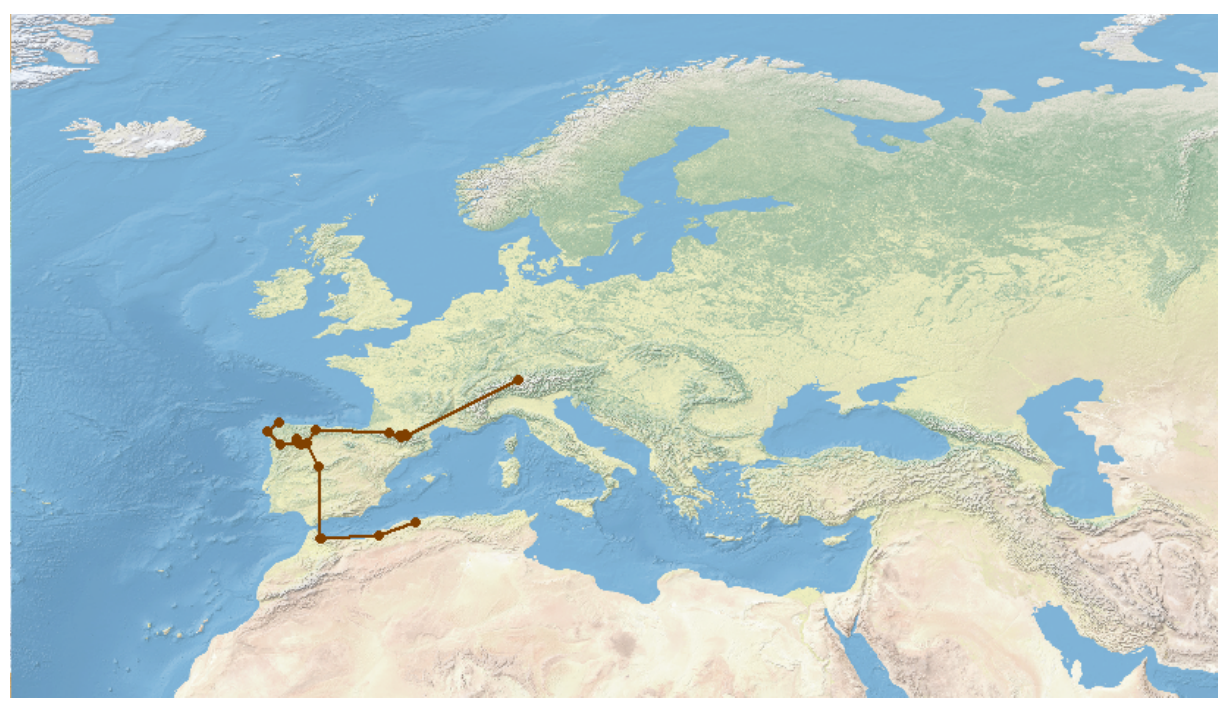
Figure 2. Individual track of Diaptomus castaneti